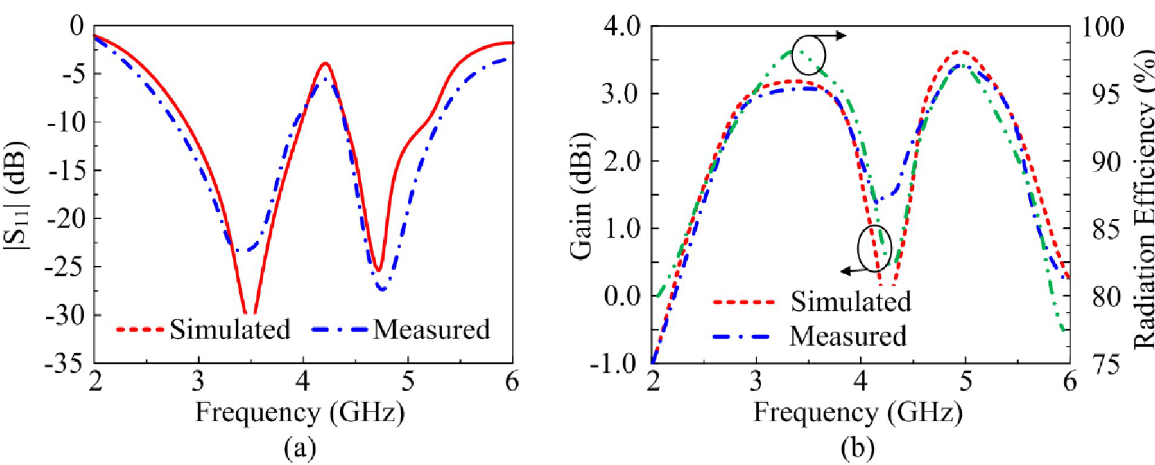
Fig 14. The reflection-coefficient, gain and radiation efficiency response of the proposed antenna when PIN diode D1 is forward biased and D2 is reverse biased. https://doi.org/10.1371/journal.pone.0276922.g014 Table 1. Antenna performance under various PIN diode switching conditions.